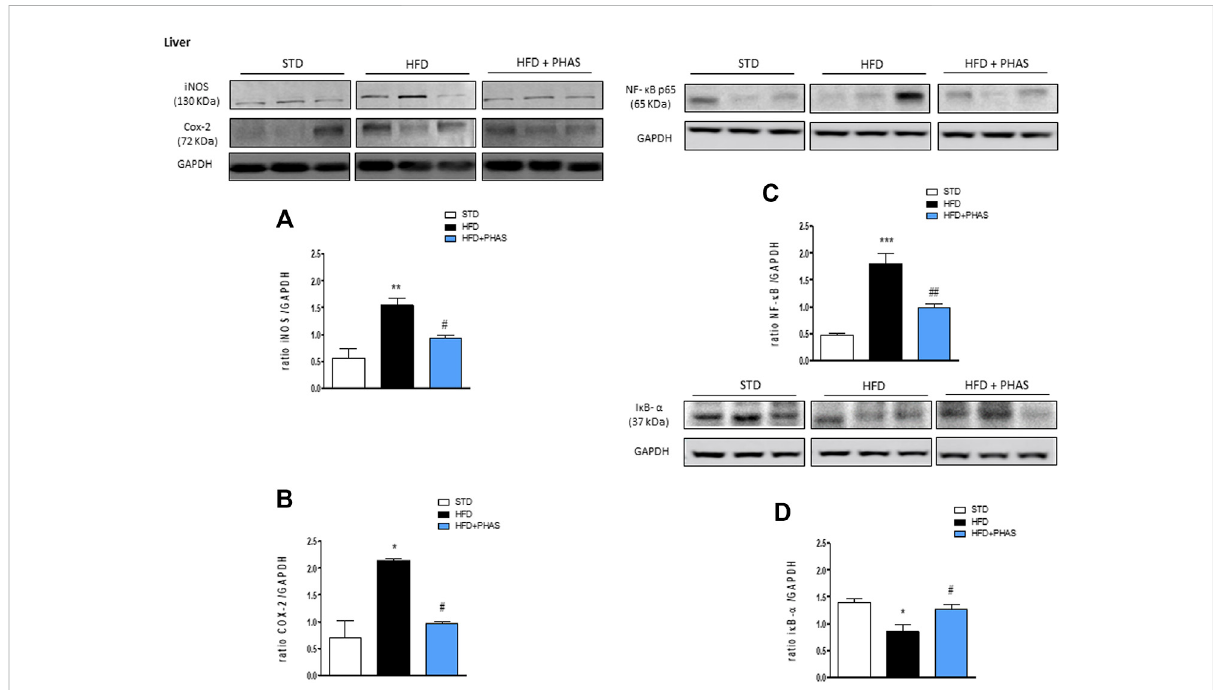
FIGURE 1 Anti-in fl ammatory effect of P. vulgaris extract (500 mg/kg, PHAS 500) measured in the liver of HFD mice: (A) iNOS; (B) COX-2; (C) NF- κ B; and (D) I κ B- α expressionsare reportedastheratioofopticaldensitiesoftheirbandsto GAPDH. Immunoblots representativewereshown. Densitometric evaluations of protein levels were reported. Data are expressed as means ± SEM ( n = 6). * p < 0.05 and ** p < 0.01, and *** p < 0.001 vs. STD; # p < 0.05 and ## p < 0.01 vs.